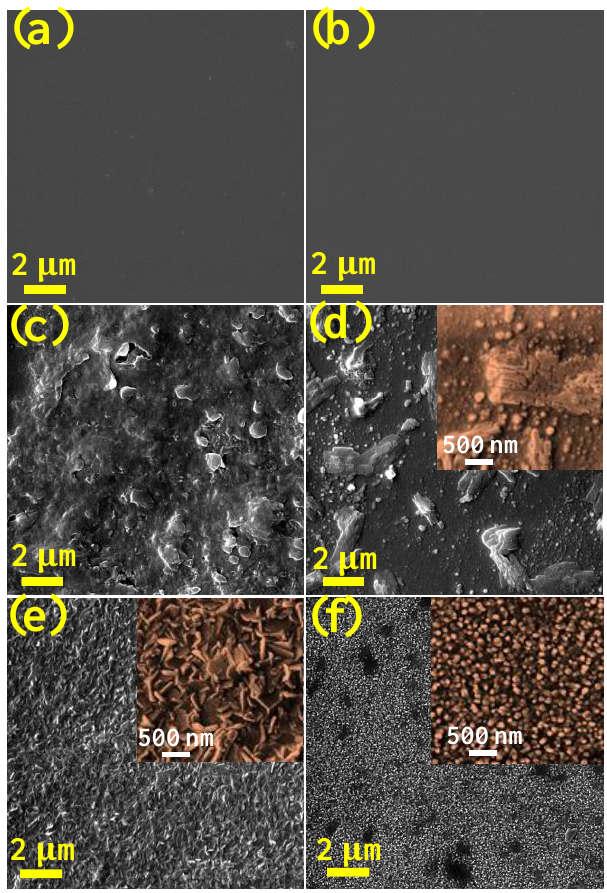
Figure 3. Low and high magnification FE-SEM images of the W films annealed at ( a ) 100, ( b ) 200, ( c ) 300, ( d ) 400, ( e ) 500, and ( f ) 600 °C in air.